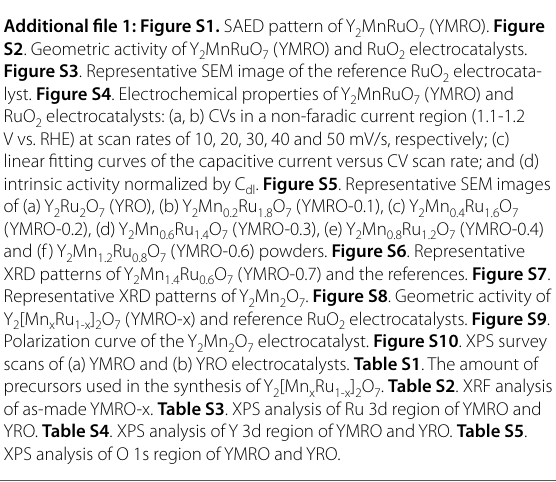
Figure S3 . Representative SEM image of the reference RuO 2 electrocata- lyst. Figure S4 . Electrochemical properties of Y 2 MnRuO 7 (YMRO) and RuO 2 electrocatalysts: (a, b) CVs in a non-faradic current region (1.1-1.2 V vs. RHE) at scan rates of 10, 20, 30, 40 and 50 mV/s, respectively; (c) linear fitting curves of the capacitive current versus CV scan rate; and (d) intrinsic activity normalized by C dl . Figure S5 . Representative SEM images of (a) Y 2 Ru 2 O 7 (YRO), (b) Y 2 Mn 0.2 Ru 1.8 O 7 (YMRO-0.1), (c) Y 2 Mn 0.4 Ru 1.6 O 7 (YMRO-0.2), (d) Y 2 Mn 0.6 Ru 1.4 O 7 (YMRO-0.3), (e) Y 2 Mn 0.8 Ru 1.2 O 7 (YMRO-0.4) and (f) Y 2 Mn 1.2 Ru 0.8 O 7 (YMRO-0.6) powders. Figure S6 . Representative XRD patterns of Y 2 Mn 1.4 Ru 0.6 O 7 (YMRO-0.7) and the references. Figure S7 . Representative XRD patterns of Y 2 Mn 2 O 7 . Figure S8 . Geometric activity of Y 2 [Mn x Ru 1-x ] 2 O 7 (YMRO-x) and reference RuO 2 electrocatalysts. Figure S9 . Polarization curve of the Y 2 Mn 2 O 7 electrocatalyst. Figure S10 . XPS survey scans of (a) YMRO and (b) YRO electrocatalysts. Table S1 . The amount of precursors used in the synthesis of Y 2 [Mn x Ru 1-x ] 2 O 7 . Table S2 . XRF analysis of as-made YMRO-x. Table S3 . XPS analysis of Ru 3d region of YMRO and YRO. Table S4 . XPS analysis of Y 3d region of YMRO and YRO. Table S5 . XPS analysis of O 1s region of YMRO and